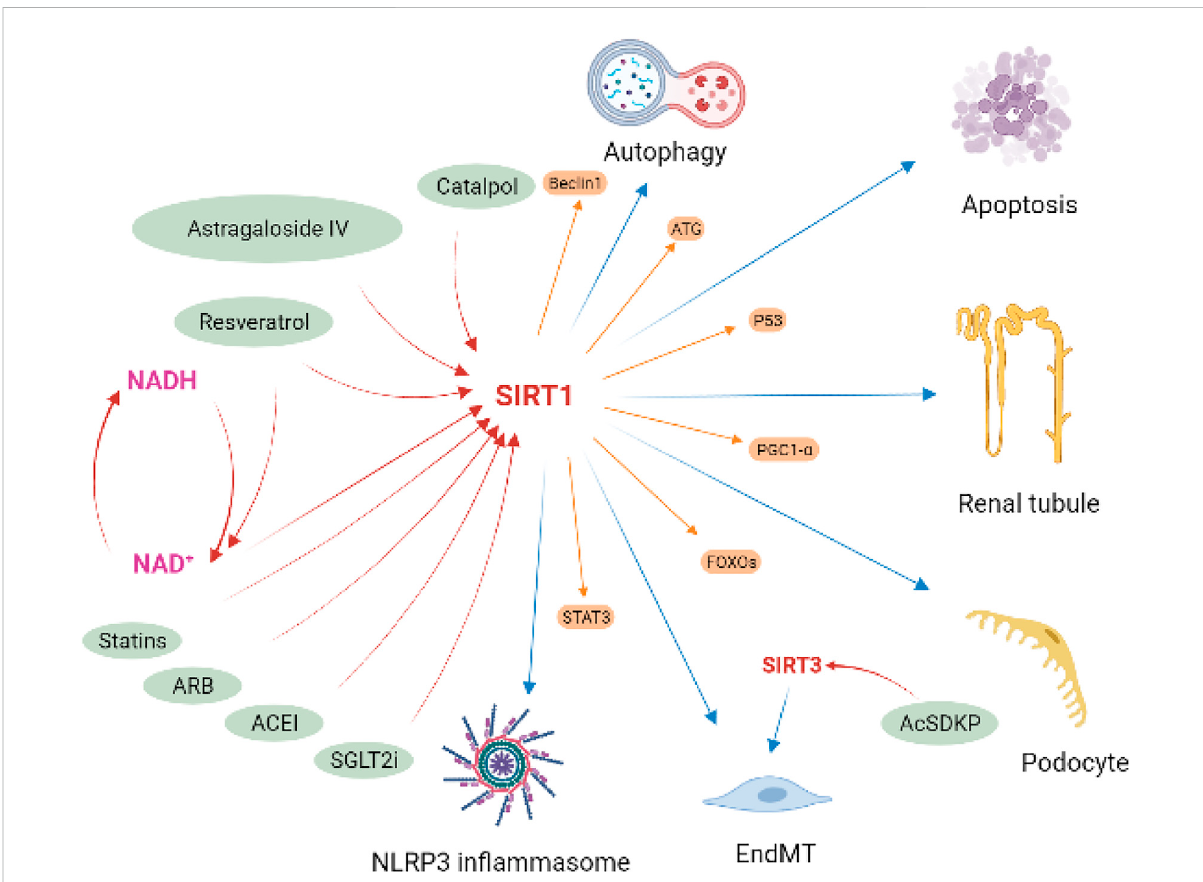
FIGURE 8 Implicationofsirt1indiabetickidneydisease. Sirt1 attenuated podocyteandtubuleinjury andapoptosis, improve endothelial-to-mesenchymal transition (EndMT), and regulated autophagy and NLRP3 in fl ammasome activation in DKD by deacetylating regulatory ATG, Beclin1, STAT3, p53, FOXOs and PGC1- α . Several drugs available in kidney disease have been shown to be partially contribute to the activation of the sirt1, including SGLT2i, ACEI, ARB, and statins. Some natural compounds have also been found to have the same effect, such as resveratrol, catalpol and astragaloside